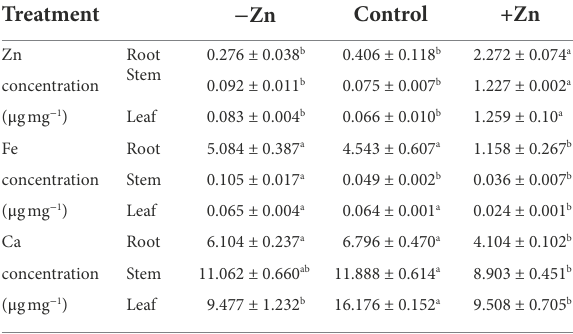
TABLE 2 Zn, Fe, and Ca concentration in the root, stem, and leaf of Ceratoides arborescens subjected to Zn-deficient (0 mM L − 1 ),